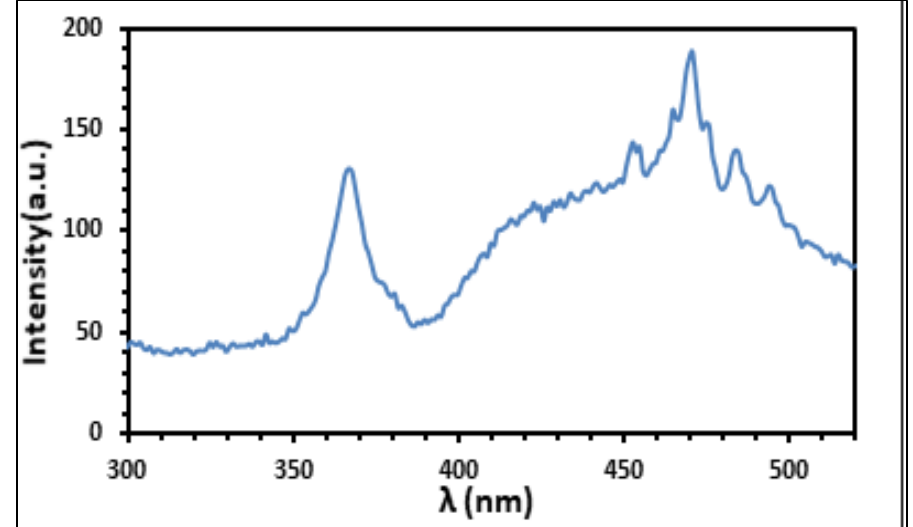
Figure 6: Photoluminescence (PL) for TiO